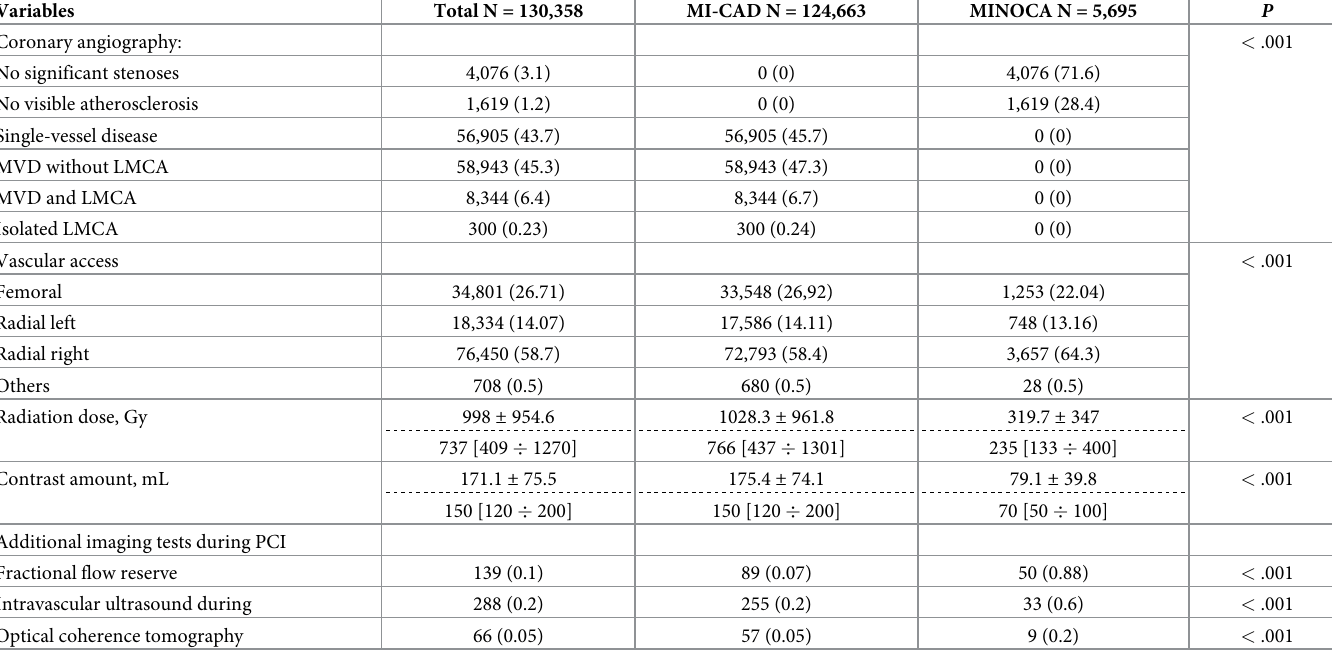
Table 2. Coronary angiography and culprit lesion characteristics in STEMI patients treated with PCI according to presence of significant coronary atherosclerosis (MI-CAD vs.